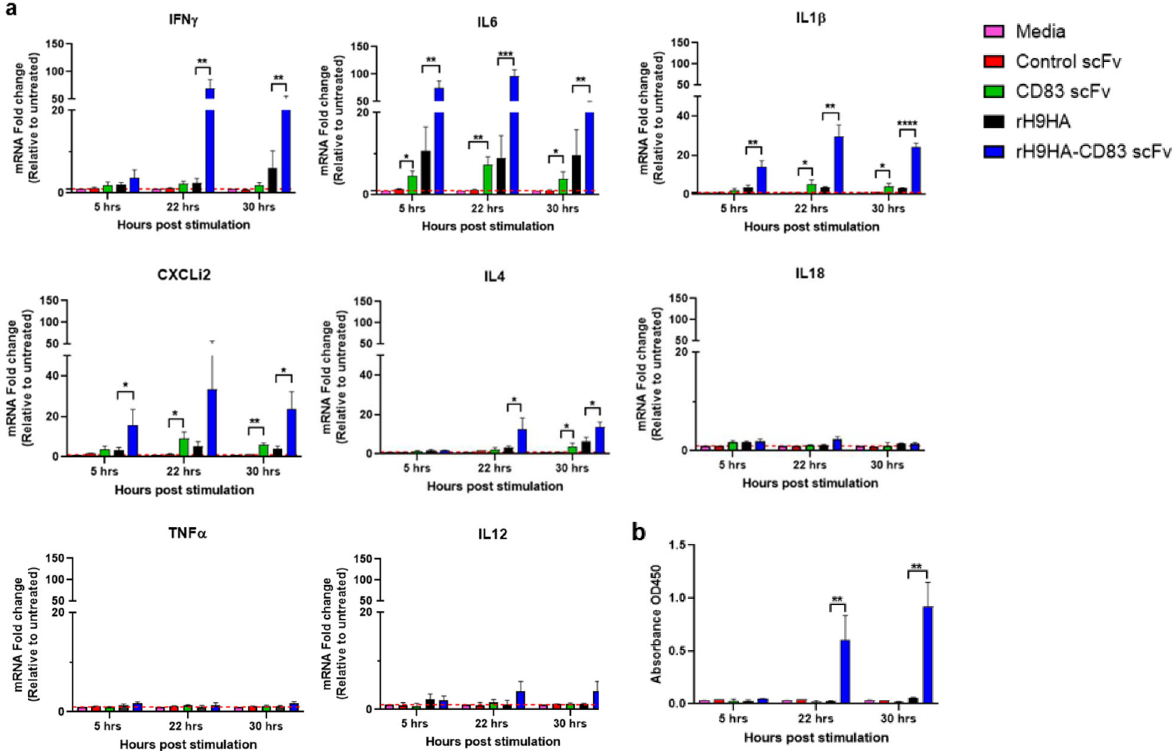
Fig. 4 Analysis of cytokine (IFN γ , IL6, IL1 β , IL4, IL18, TNF α , and IL12) and chemokine (CXCLi2) mRNA levels in splenocytes upon stimulation with CD83 scFv, rH9HA, and rH9HA-CD83 scFv. a Cytokines and chemokine mRNA levels in splenocytes analysed using qRT-PCR. b IFN γ protein level analysed using ELISA. For a : splenocytes were isolated from the spleen of 3-week-old SPF chickens using Histopaque 1083 and stimulated with 10 μ g of CD83 scFv/rH9HA/rH9HA-CD83 scFv for 5, 22, and 30 h in vitro. Stimulated splenocytes were harvested for RNA extraction and expression levels of the respective cytokines and chemokine were measured by qRT-PCR. Data were calculated using 2 − ΔΔ CT approach ( n -fold change compared to the media only control group) and reported as values normalised to the expression level of a housekeeping gene RPLPO1. For b : supernatants from the stimulated splenocytes were analysed for the presence of IFN γ by ELISA. Data are represented as mean ± SD and analysed by one-way ANOVA followed by Tukey ’ s multiple comparison test. *** p < 0.001 ** p < 0.01 * p < 0.05. The data represent three independent